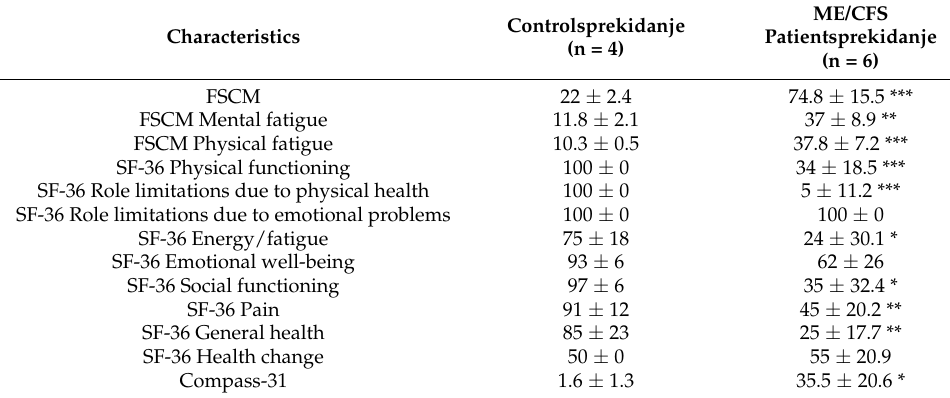
Table 2. Clinical questionnaires.